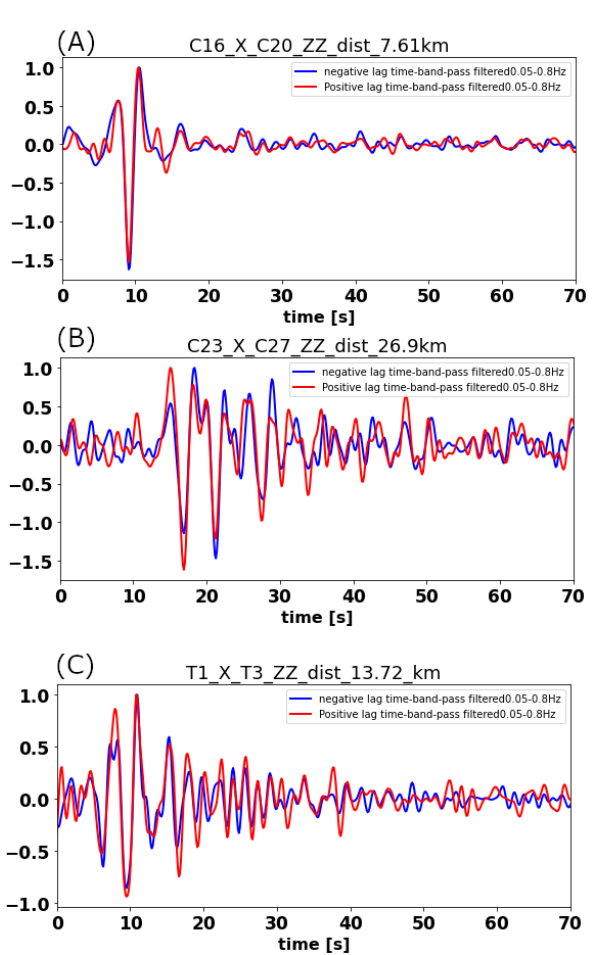
Figure 4. Comparison between the positive and negative lag time signals of station pairs ( A ) C16– C20, ( B ) C23–C27, and ( C ) T1–T3. The name of station pair, type of receiver (zz = vertical) and the inter-station distance in km is given at the top of every panel. Red lines show the positive lag time signal, flipped onto the negative time axis. The selected range of frequency is 0.05–0.8 Hz. The good overlap between positive and negative lag time signals confirms the symmetry in time domain cross-correlation and is taken as indication of the spatial homogeneity of source